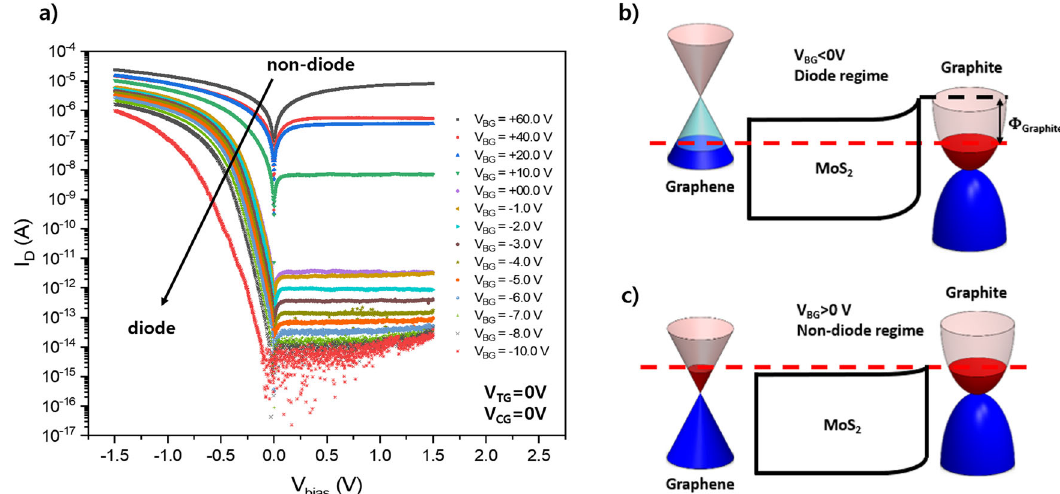
Fig. 2 Characteristic I D -V bias curve for various V BG and its band diagram. a Characteristic I D -V bias curve in the range of V BG = − 10 to + 60 V. As V BG decreases, change from non-diode to diode behaviour is observed. b Band diagram when V BG < 0 (diode regime). Owing to the larger work function of graphite than that of graphene, the device becomes a graphite/MoS 2 -interface Schottky barrier-dominant Schottky diode. c Band diagram when V BG > 0 (non-diode regime). As V BG increases, the work function of graphite decreases, and the Schottky barrier height of the graphite/MoS 2 interface